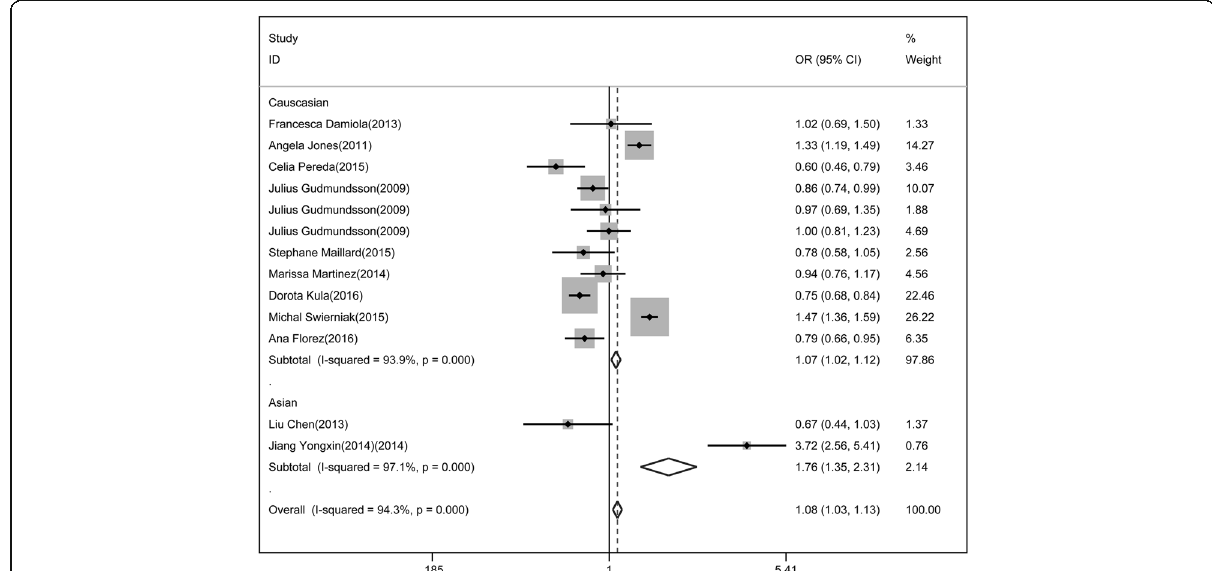
Fig. 3 Association of rs944289 polymorphism with differentiated thyroid